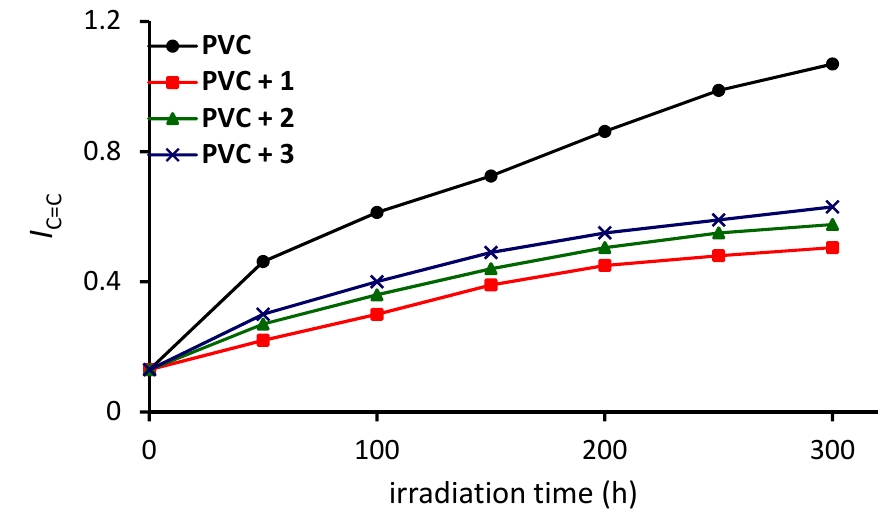
Figure 3. Changes in the I C=C index of PVC films.